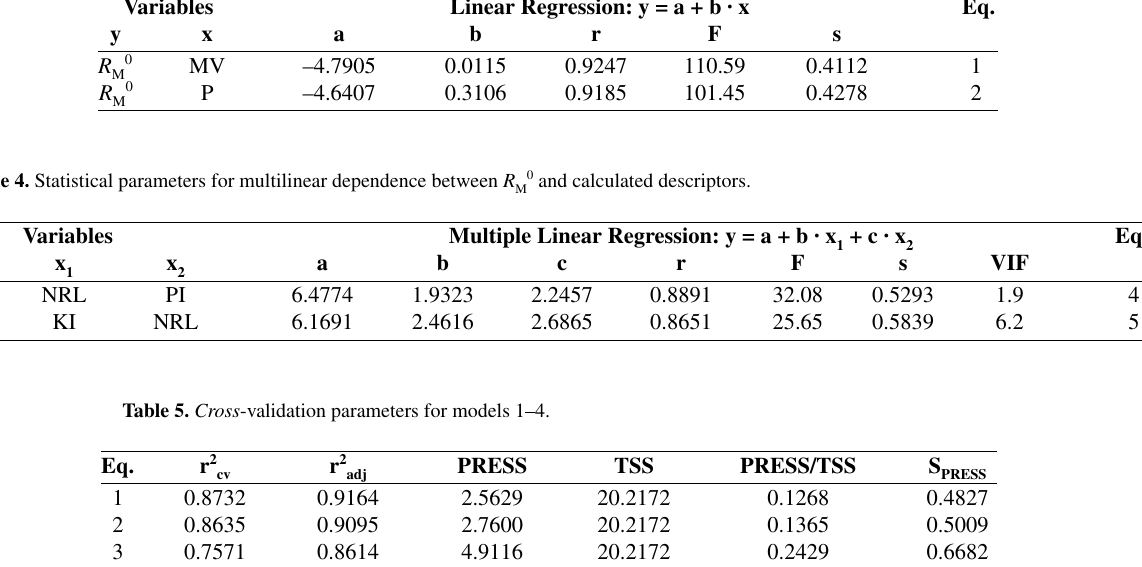
Table 3. Statistical parameters for linear dependence between R M0 and calculated descriptors. Variables